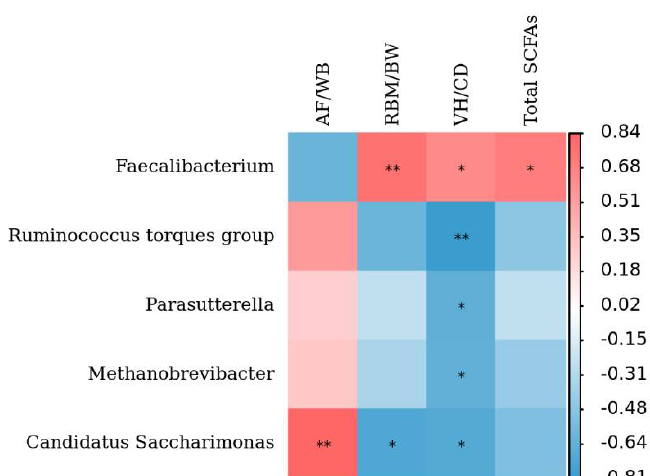
Figure 6. Heatmap of Spearman’s correlation analysis between the cecal microbiota composition and the growth performance indexes of geese. The red color represents a positive correlation, while the blue color represents an inverse correlation. ZG, Zi Goose; FG, Xianghai Flying Goose; AF/WB, abdominal fat index; RBM/WB, right breast muscle index; (abdominal fat index and right breast muscle index were defined as the abdominal fat mass and right breast muscle weight divided by the body weight, respectively); VH/CD, villus height/crypt depth; Total SCFAs, total short-chain fatty acids. * p < 0.05, ** p <